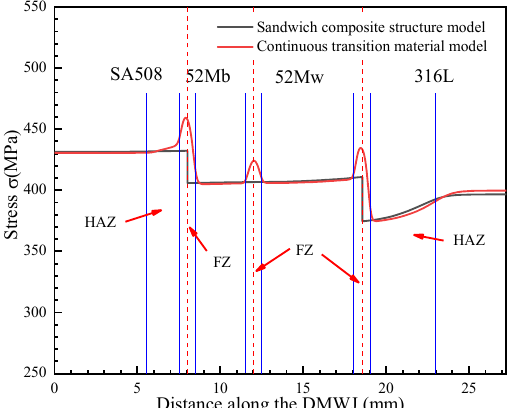
Figure 12. Stress along the DMWJ under an axial load.